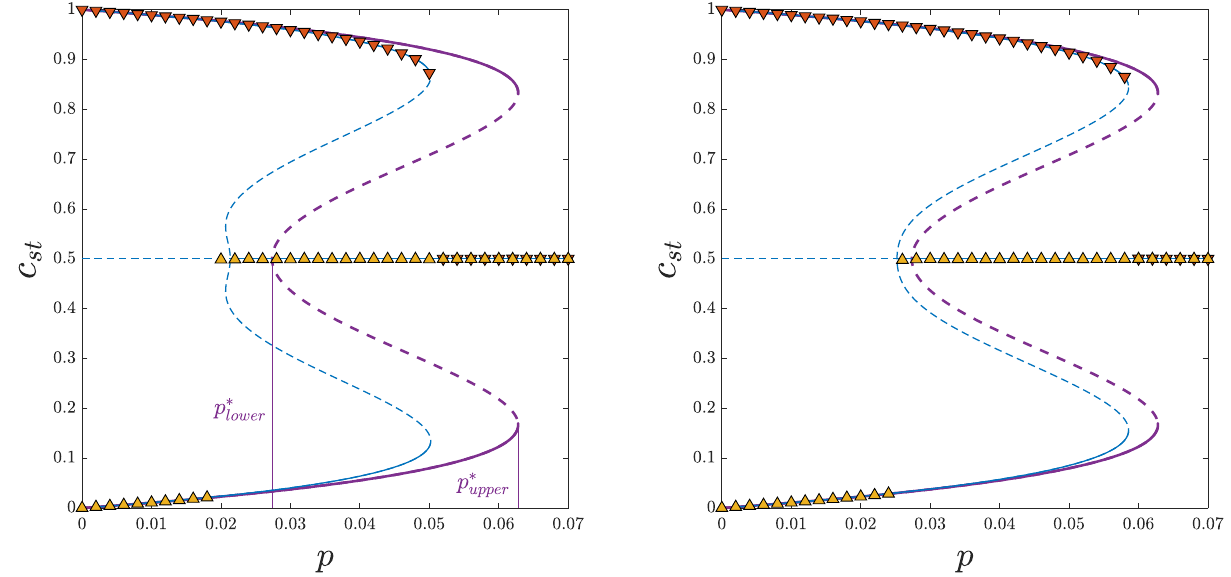
Figure 2. Dependence between the stationary concentration of up-spins c st and the probability of anticonformity p obtained within MFA (thick purple lines), PA (thin blue lines) and MC simulations (symbols) for q a = 4 and q c = 10 and: k = 50 (left panel), k = 150 (right panel). Solid lines denote stable and dashed lines unstable fixed points. Results from the initial concentration of up-spins c 0 = 1 are presented in the upper parts of the panels (orange down-pointing triangles), whereas for c 0 = 0.5 in the bottom parts (yellow up-pointing triangles). Thin purple vertical lines have been added to denote spinodals obtained from MFA. Error bars corresponding to the standard deviation of stationary concentration are smaller than the size of the